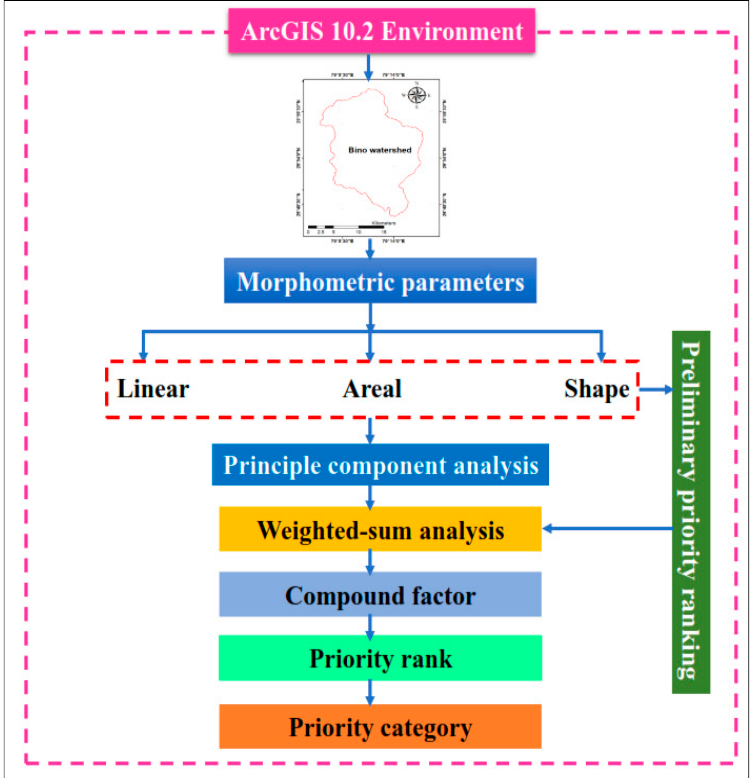
Figure 4. Working flow chart of nine sub-watershed prioritization of BW.